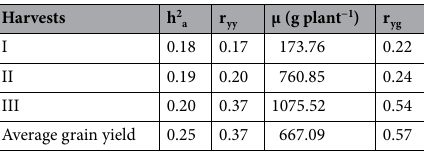
Table 1. Narrow-sense heritability (h 2 a ), phenotypic selection accuracy (r yy ), predictive ability (r yg ), and average grain yield (µ).